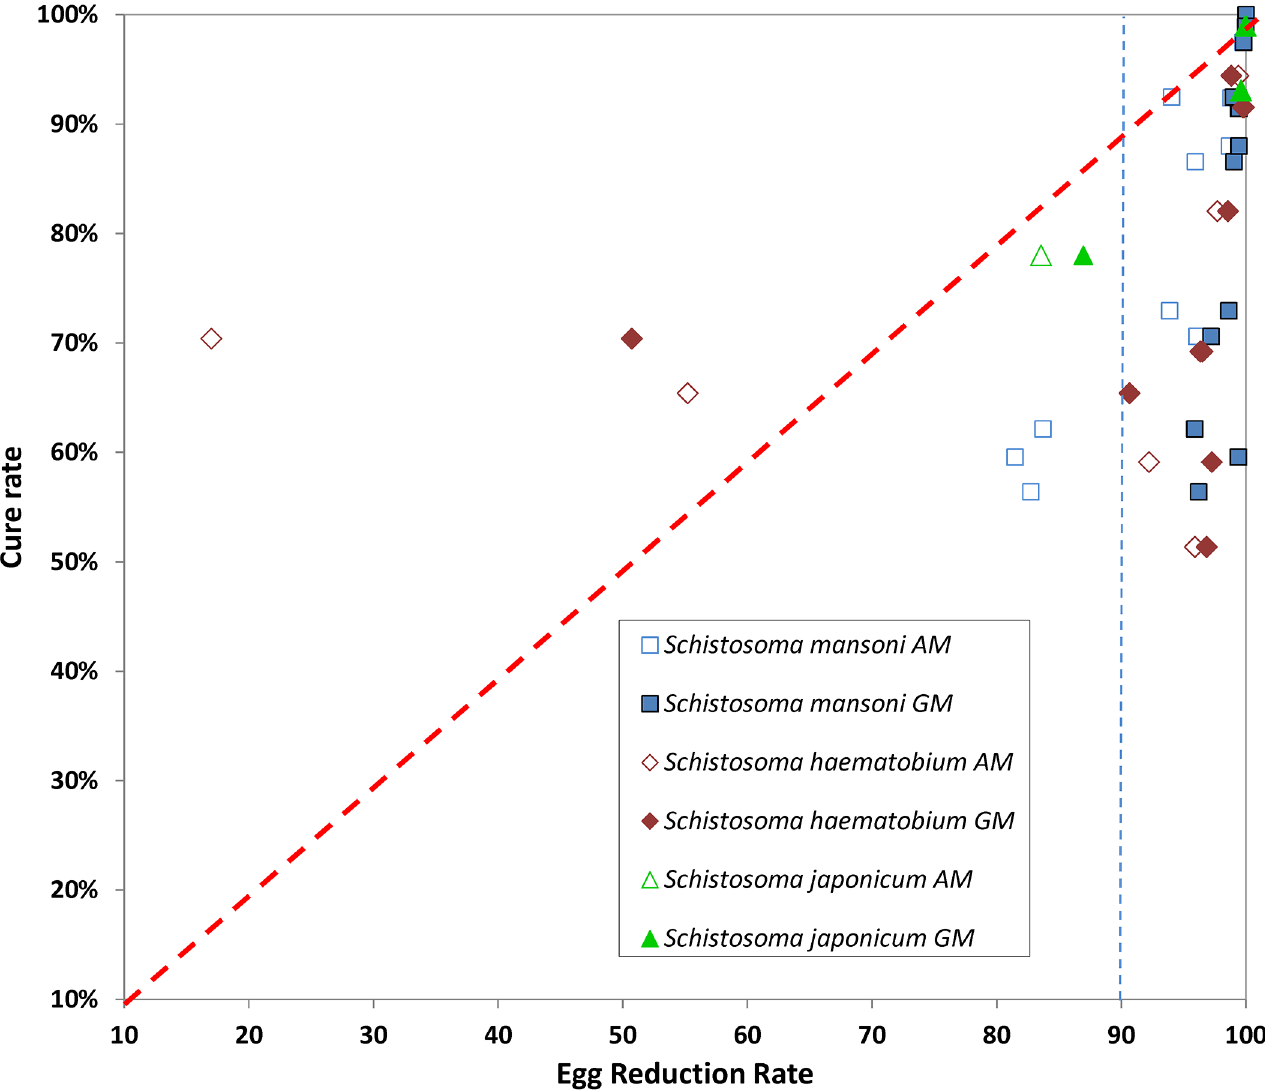
Fig 5. Comparison between egg reduction rate (ERR) and cure rate (CR). The red dashed diagonal line of no difference between the ERR calculated with both